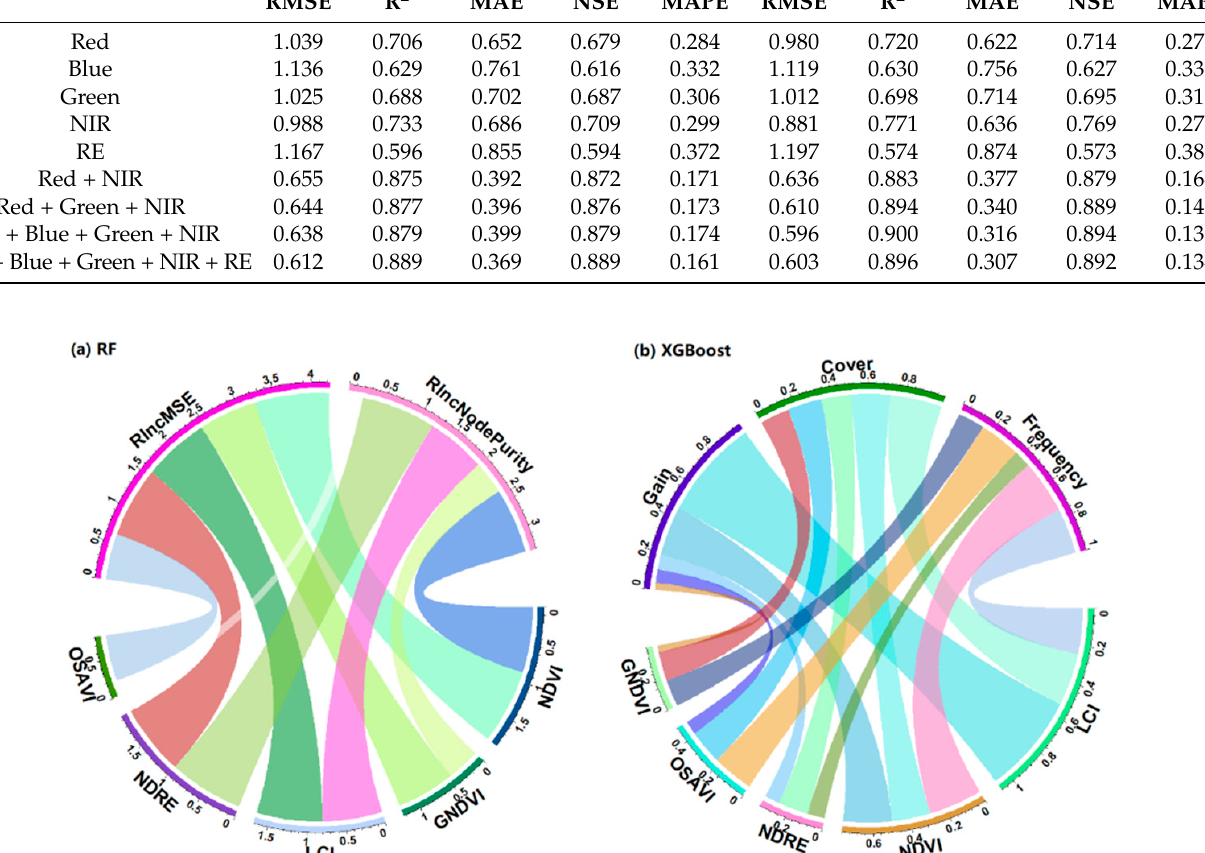
Table 3. Statistical evaluation for RF and XGBoost with vegetation indexes (VIs) as input variables. Bands (B)